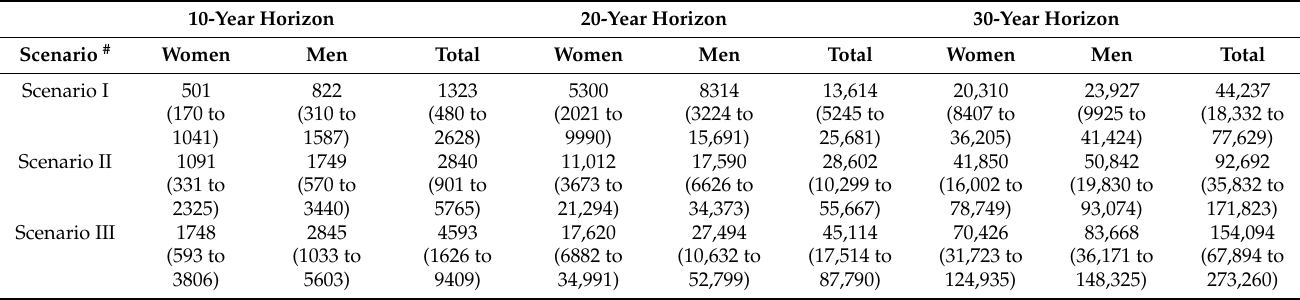
Table 5. Projected cumulative mean QALY changes (95% CIs) compared with the baseline situation in the year 2017.